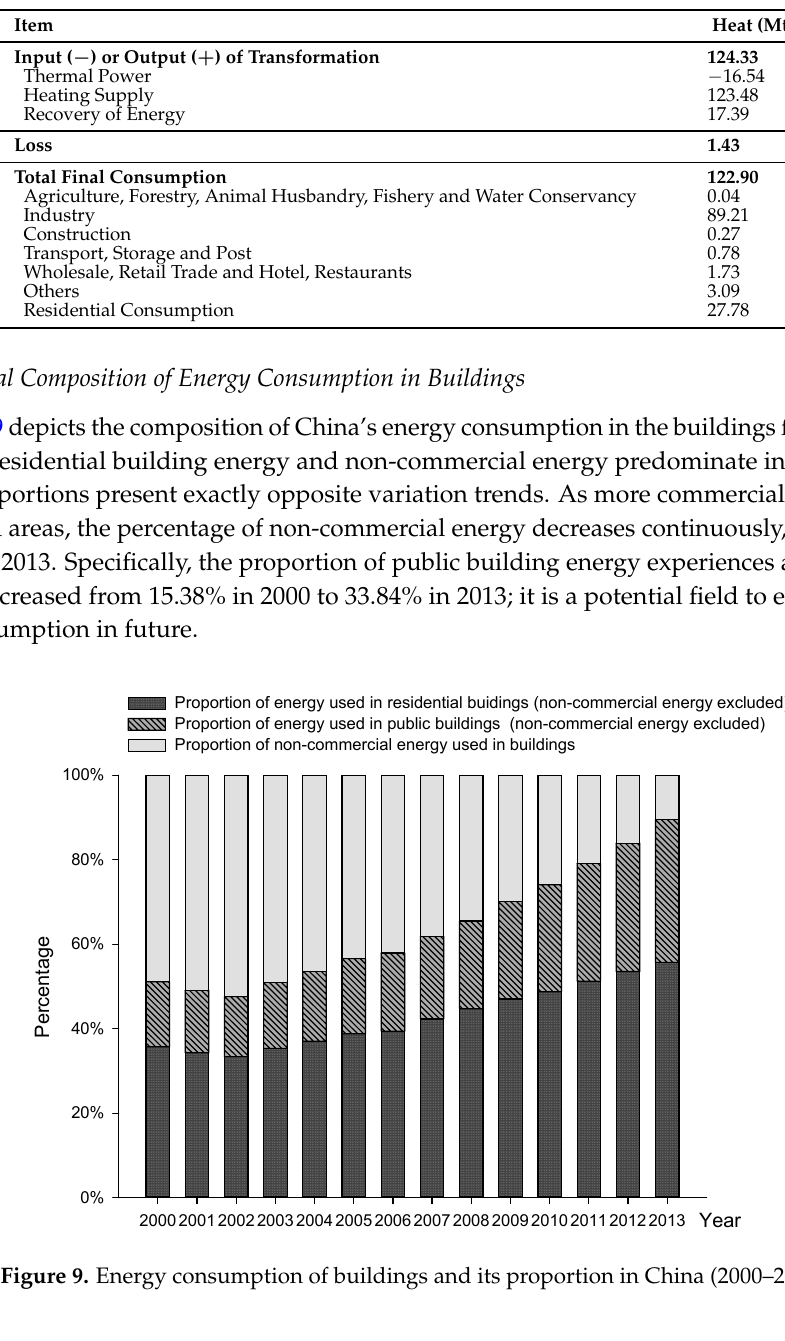
Table 5. Part of 2013 Energy Balance of China (standard quantity).